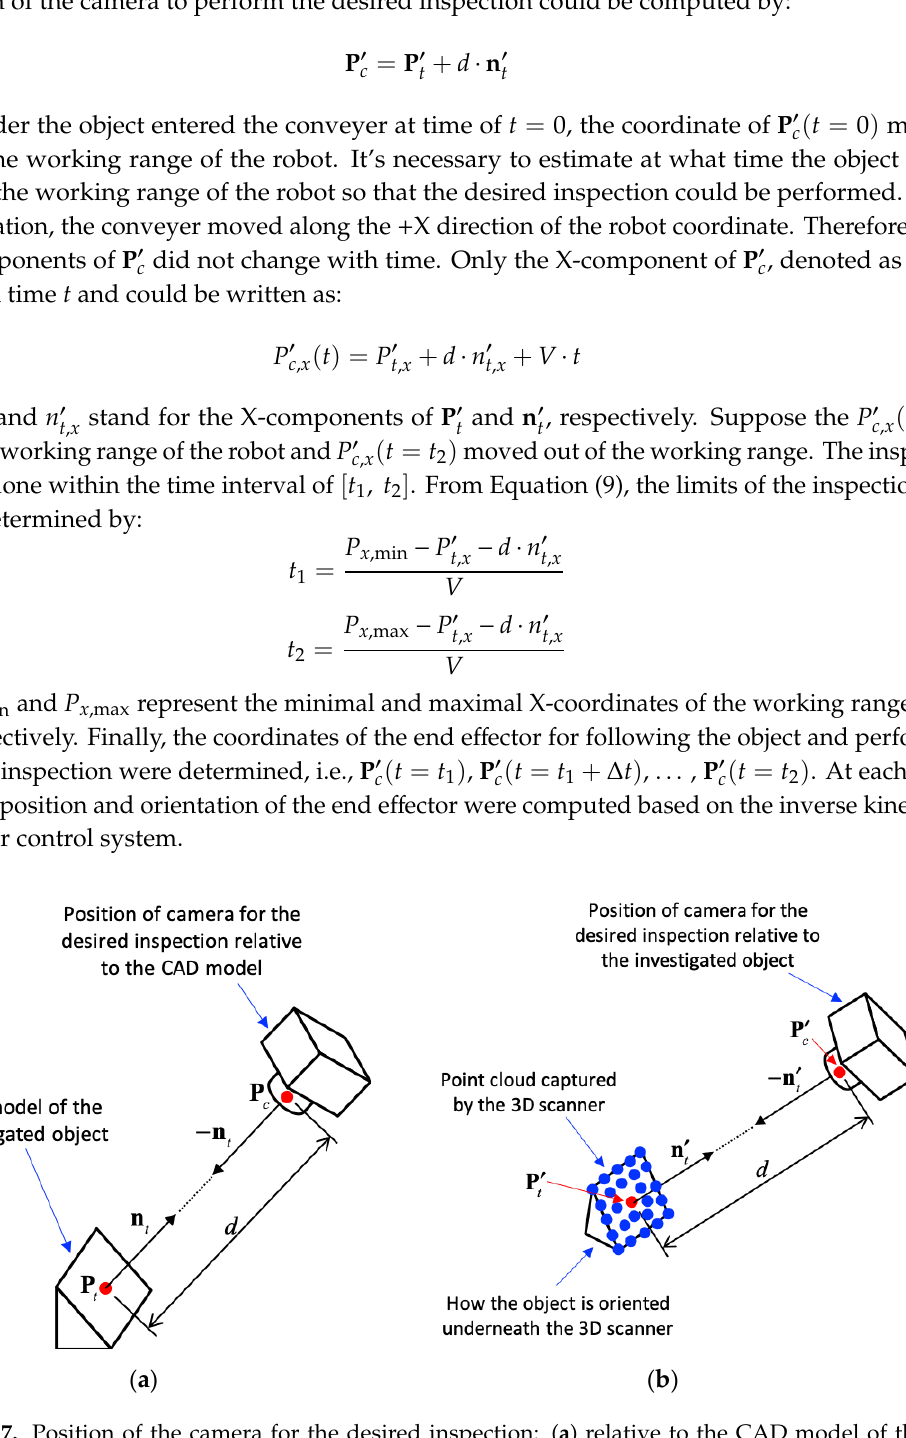
Figure 7. Position of the camera for the desired inspection: ( a ) relative to the CAD model of the investigated object; ( b ) relative to the point cloud of the object captured by 3D scanner.